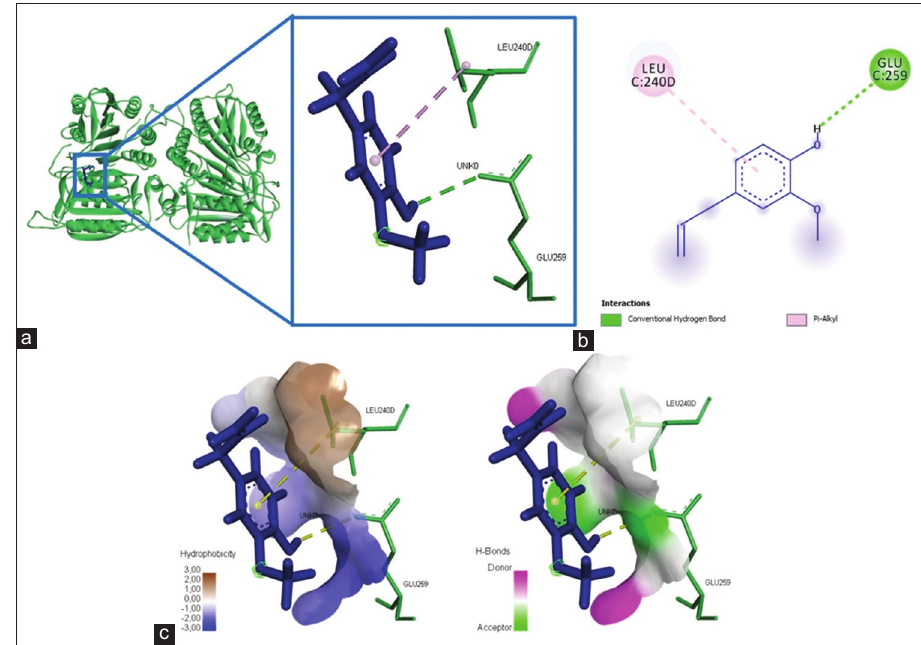
Figure-9: The visualization of the three-dimensional and two-dimensional interaction between phenolic compounds (eugenol) and caspase-9. (a) Three-dimensional structural interaction between the ligand eugenol (blue) and caspase-9 (green). (b) This interaction is established by hydrophobic hydrogen bonds on the active site of caspase-9, namely, Glu259 and Leu240, which can be seen in the two-dimensional (b) and three-dimensional (c) structures.